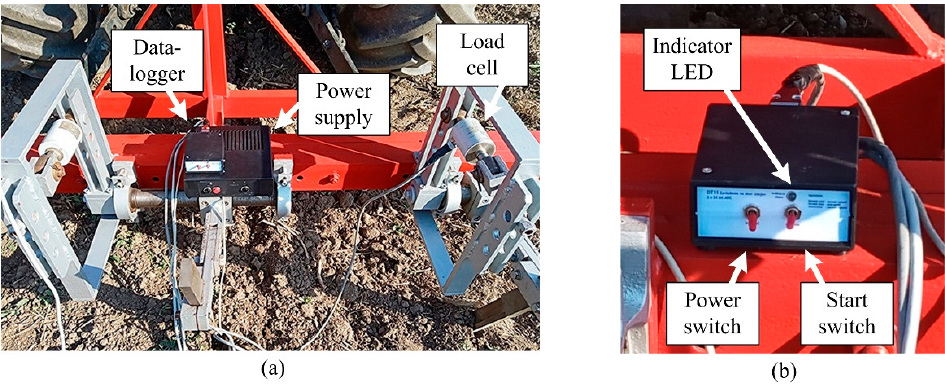
Figure 10. Datalogger: ( a ) Datalogger connected in the measurement system; ( b ) Controls and sig ‐ nalization.